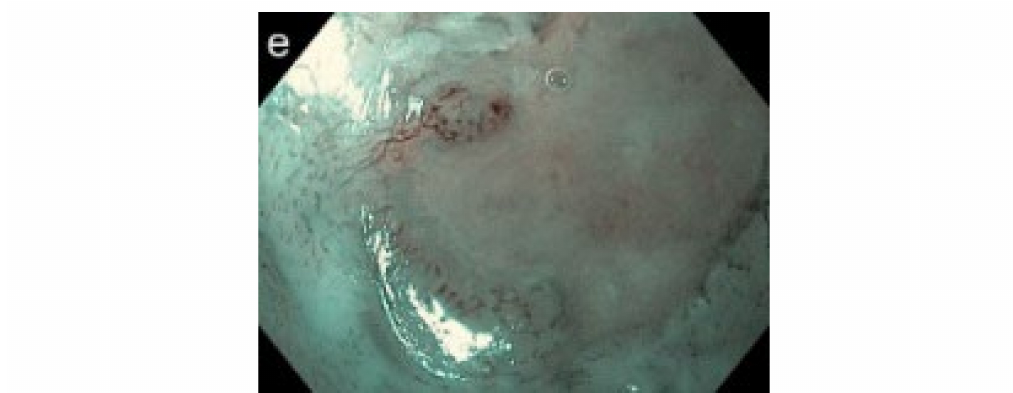
Figure 4. Five types of IPCL classification. Types 0 ( a ), I ( b ), II ( c ), III ( d ), and IV ( e ).